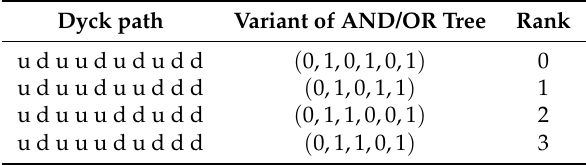
Table A1. Ranking the combinatorial set of Dyck n -paths with m return steps for n = 5 and m =